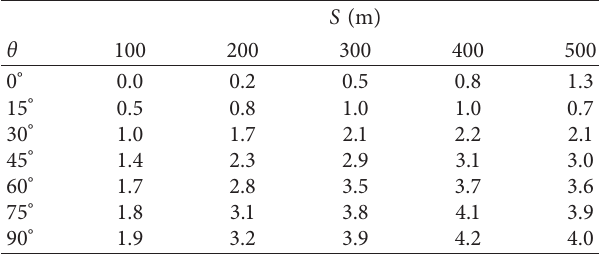
Table 4: c 1 as a percentage of half-height of radial wall jet at lo- cation A.